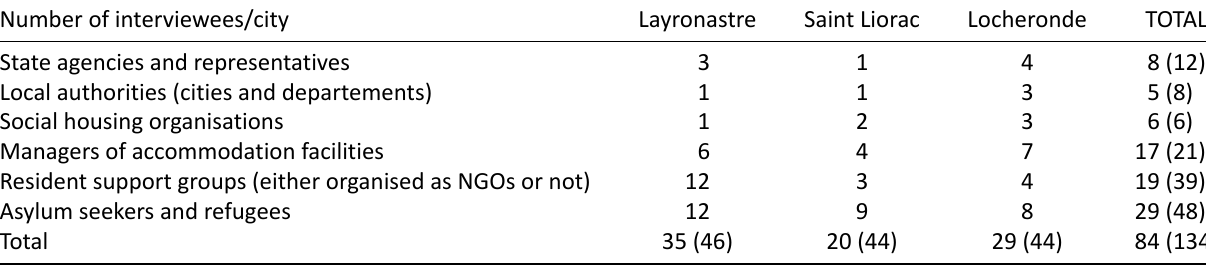
Table 2. Types of actors who participated in the 84 semi-structured interviews. Number of